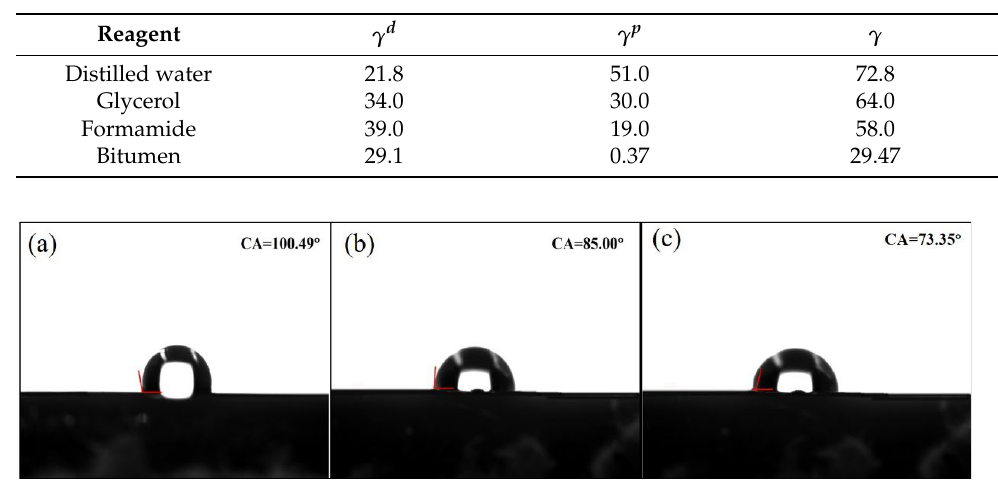
Figure 8. Contact angle of bitumen with probe liquid: ( a ) distilled water; ( b ) glycerol; ( c ) formamide.